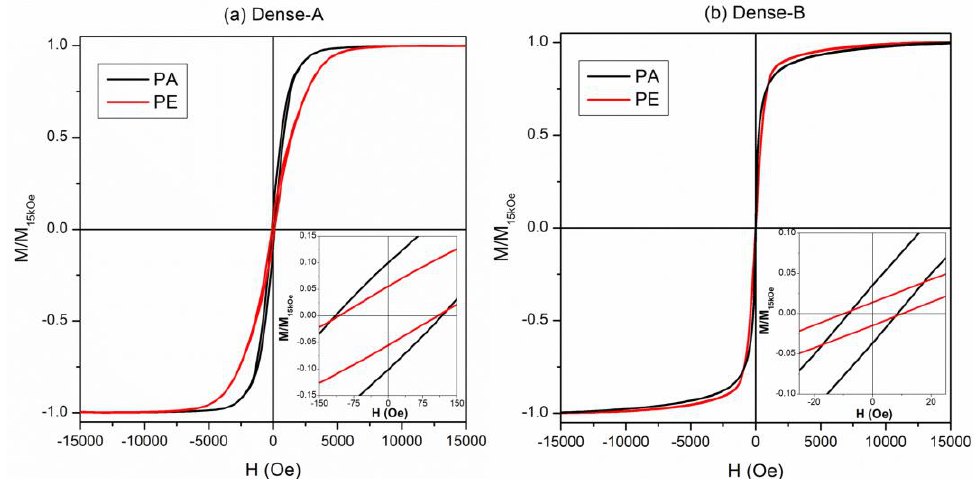
Figure 8. Room-temperature hysteresis loops of ( a ) Dense-A and ( b ) Dense-B NW arrays by applying H along the direction parallel (PA) and perpendicular (PE) to the major axis of the NWs. Inset: enlargement of hysteresis loops at a low magnetic field. Table 2. Magnetic properties evaluated from hysteresis loops reported in Figures 8 and 9. Saturation field (H s ), coercive field (H c ), magnetic susceptibility evaluated at the coercive field χ Hc , and the normalized magnetization remanence (M r /M s ). The nomenclature for the NW arrays is the same as in Table